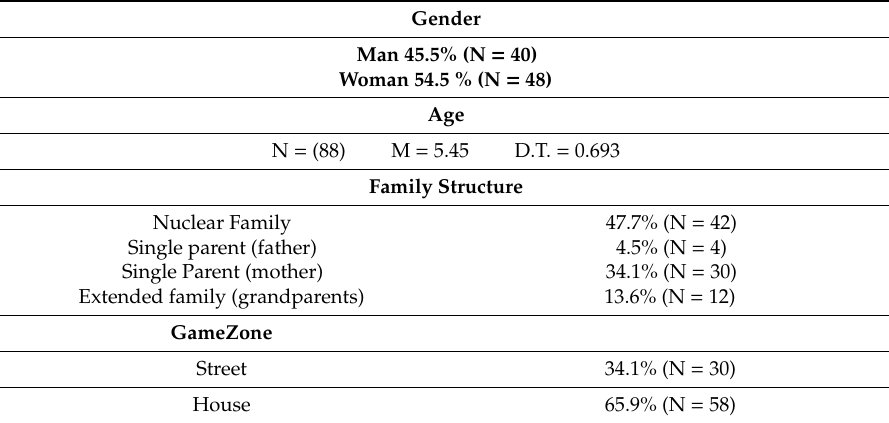
Table 1. Data of the Sample.